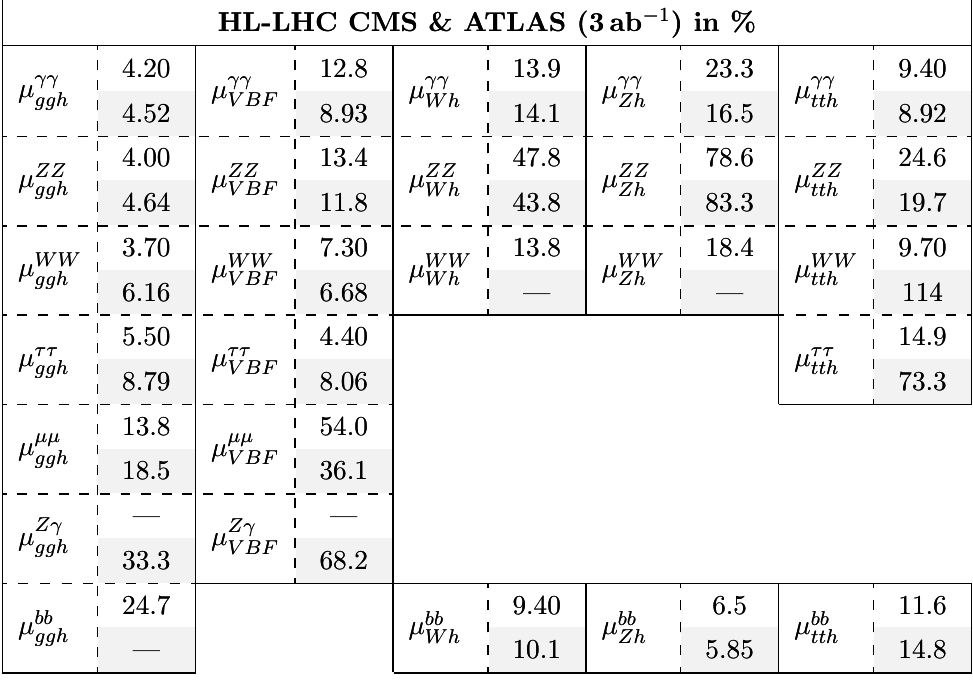
Table 7 . HL-LHC projections for CMS and ATLAS for luminosities of 3 ab (cid:0) 1 individually. The white cells are for CMS and the grey ones are for ATLAS. The details of correlations and the exact use of these numbers in the (cid:12)ts can be found in the